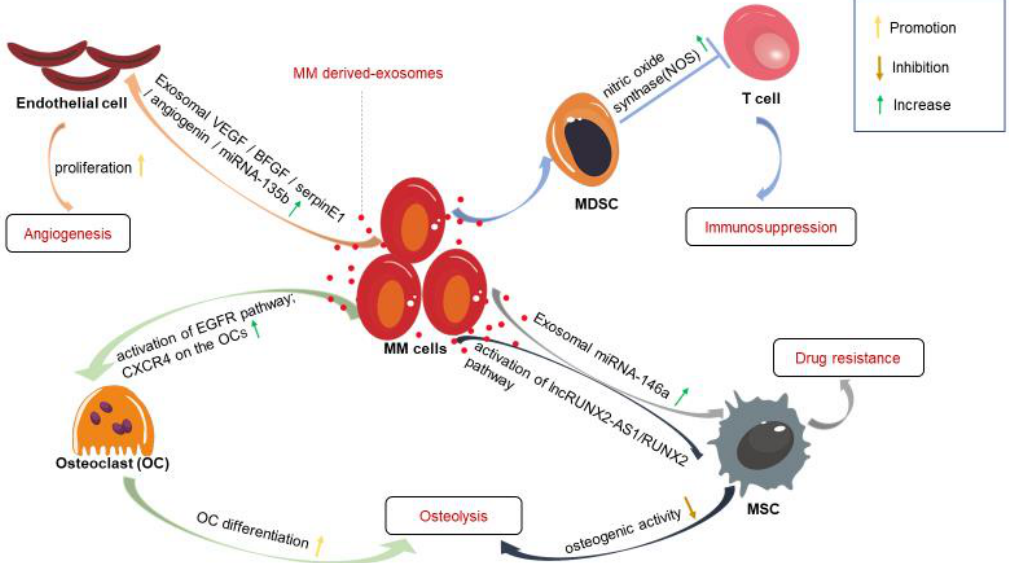
Figure 3. The effects of MM-derived exosomes on different types of cells in the BMM. MM-derived exosomes act on different types of cells in the BMM, thereby creating an environment that benefits the survival and growth of MM cells. MDSC, myeloid-derived suppressor cell; MSC, mesenchymal stem cell; OC, osteoclast; VEGF, vascular endothelial growth factor; CXCR4, cysteine X cysteine receptor 4; BFGF, basic fibroblast growth factor; EGFR, epidermal growth factor receptor.